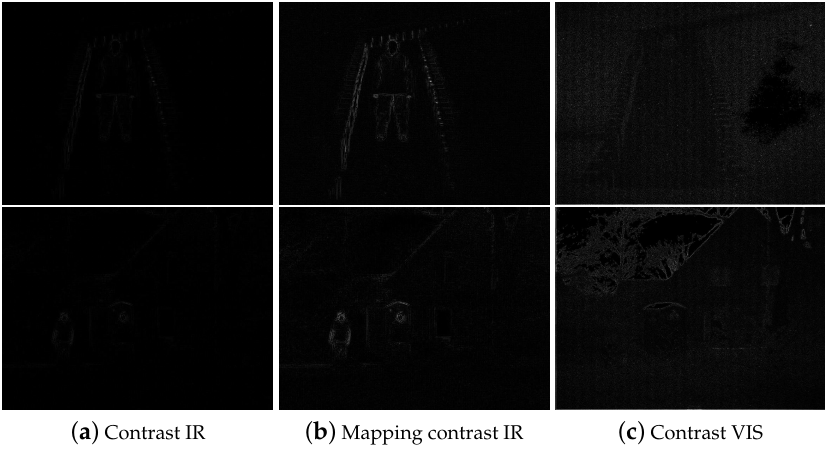
Figure 4. Contrast measure results of the stretched IR and VIS